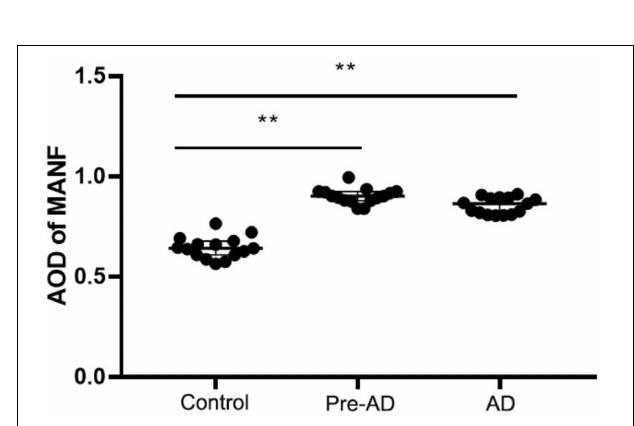
FIGURE 8 | Increased MANF expression in the ITGC of pre-AD and AD groups. Overall expression in both groups was higher than in the control group, while the expression level was lower in the AD group than in the pre-AD group, although the difference was non-significant. ** P < 0.05 vs. control